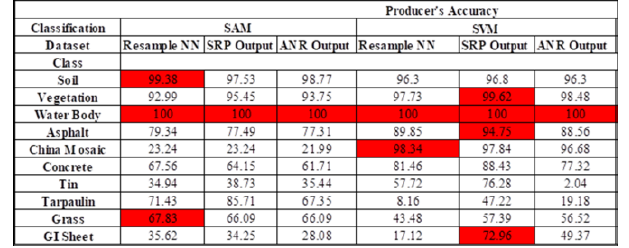
Table 4. PA for Individual Class of Three Datasets The highlighted values indicate the best possible accuracies.